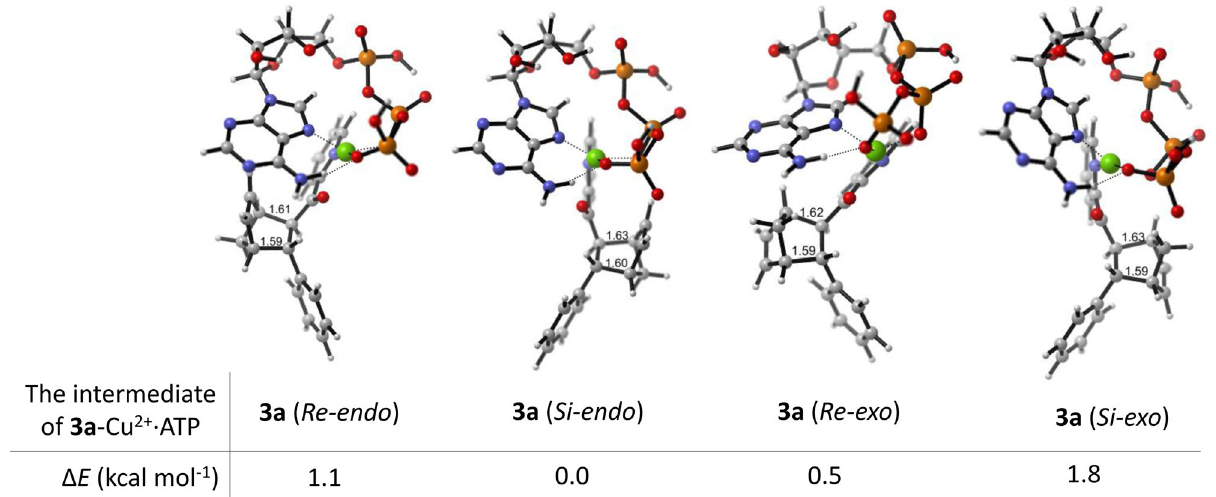
Supplementary Fig. 24. The intermediates of 3a -ATP ⋅ Cu 2 + and their relative electronic energies ( Δ E).